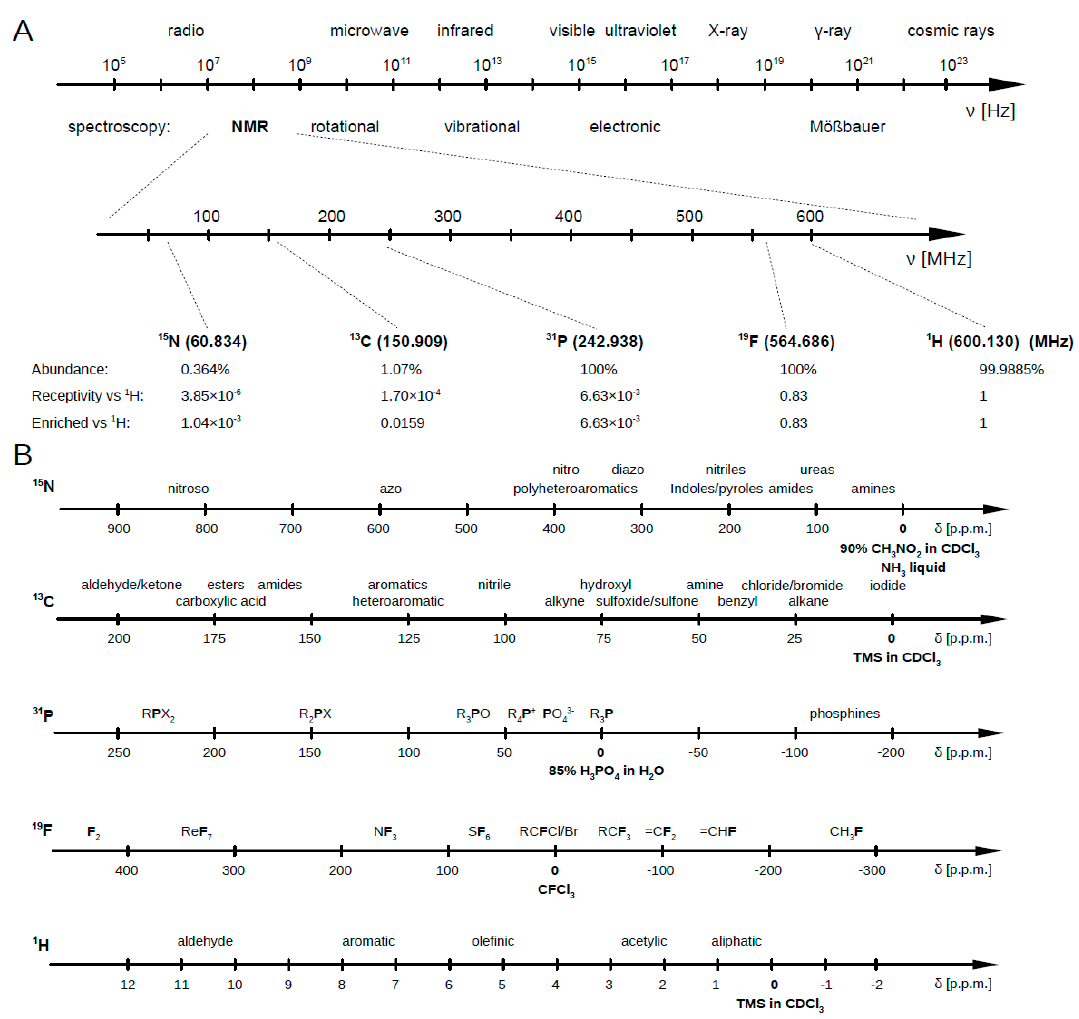
Figure 2. The electromagnetic nature of the NMR spectroscopy of the most common nuclei for metabolomics studies. ( A ) Frequency scale ranges and types of spectroscopies that correspond to them. The NMR frequency range for the most commonly used nuclei at 600 MHz proton frequency along with the natural abundances of the nuclei are also given. ( B ) Typical ppm ranges for the 15 N, 13 C, 31 P,